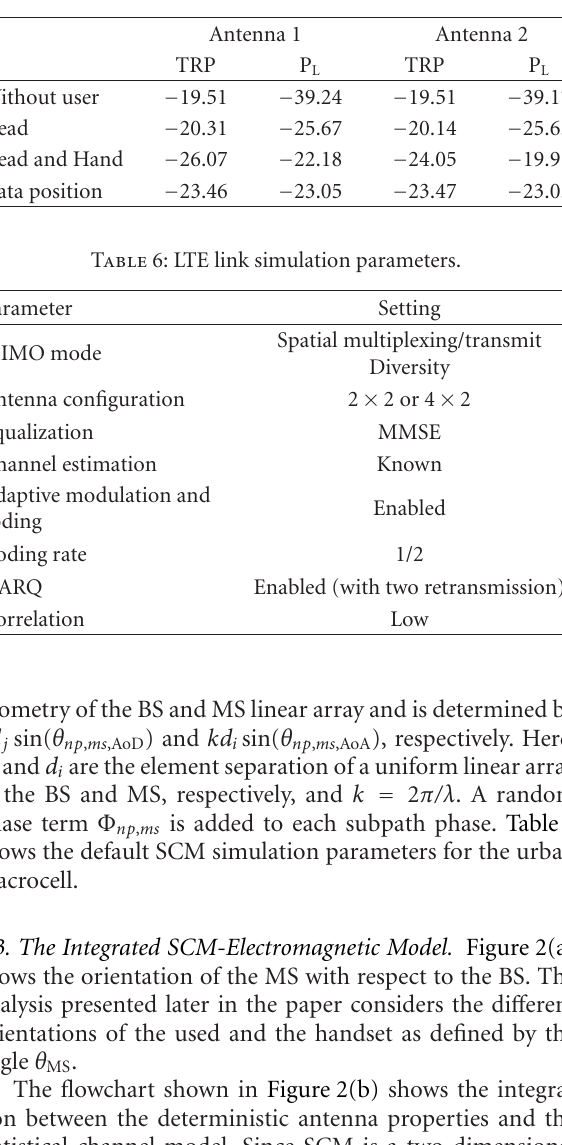
Table 5: The total radiated power (TRP) and power loss ( P L ) for PIFA (in d B).